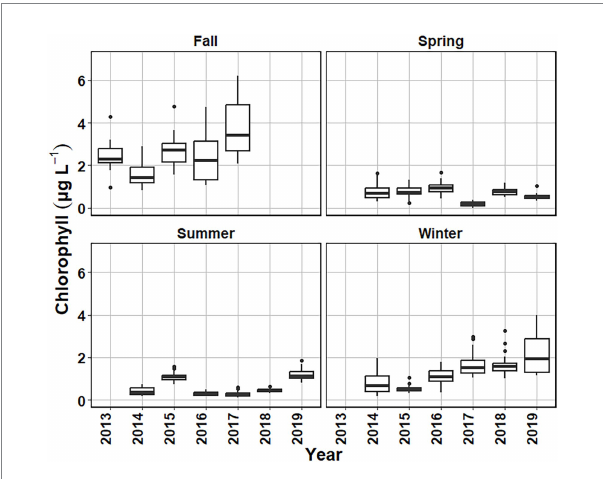
FIGURE 8 Surface chlorophyll ( μ g L − 1 ) boxplots for each sampling date arranged by season and year from October 2013 to August 2019.